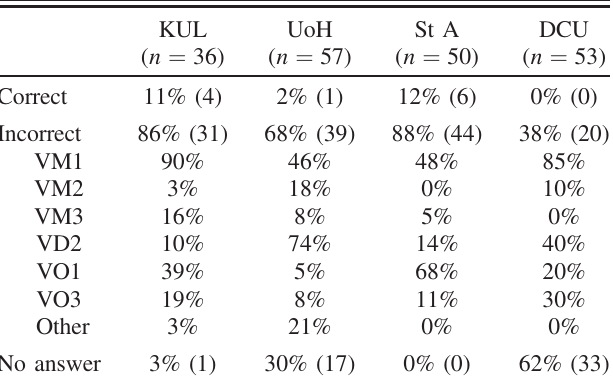
TABLE III. Summary of responses to question 3(a) [Fig. 1(c)]. Incorrect responses are associated with the errors listed in Table I. Since students can exhibit multiple difficulties in a single sketch, the percentages do not sum to